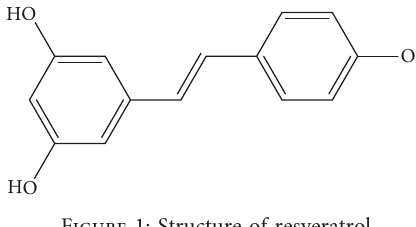
Figure 1: Structure of resveratrol.